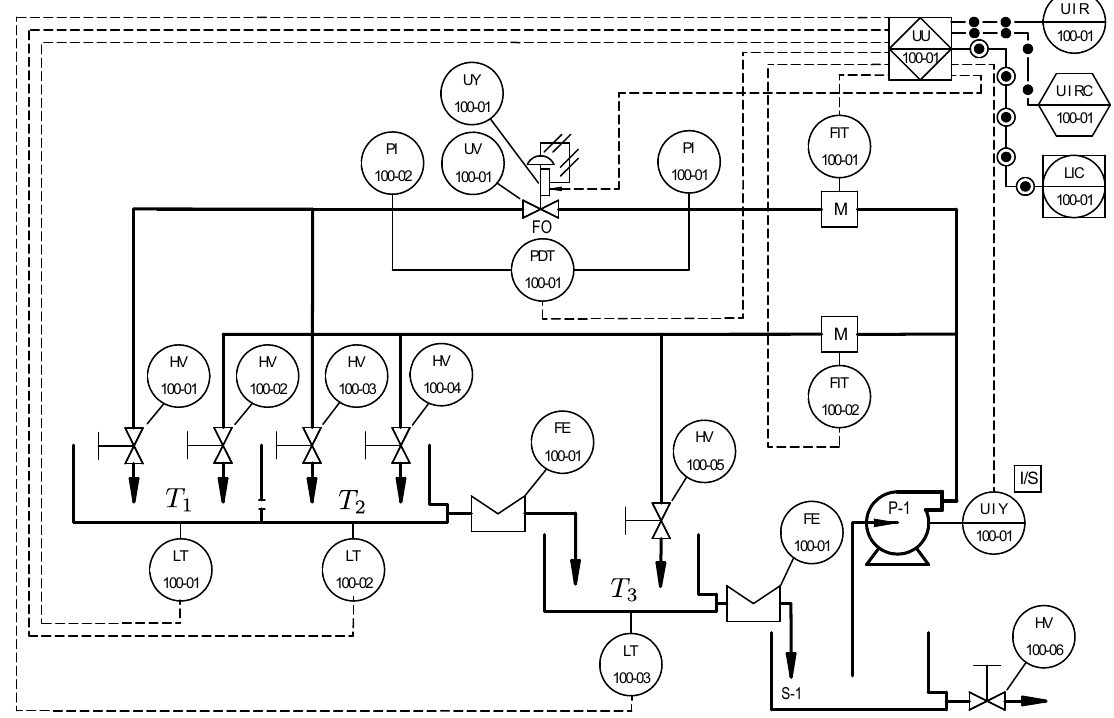
Figure 1. Simplified process and instrumentation diagram (P&ID)